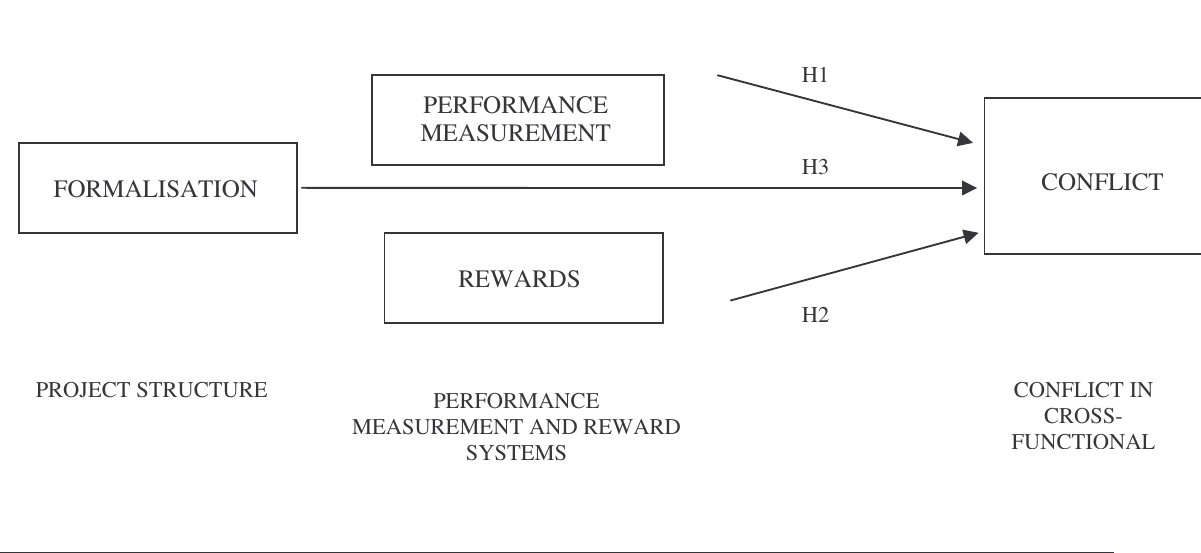
Figure 1: Organisational control mechanisms and